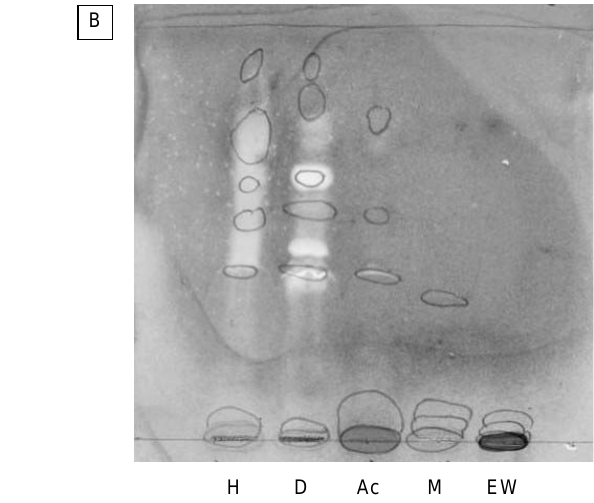
FIG. 1 Gunnera perpensa extracts separated on a TLC plate A: solvent system BEA (benzene:ethyl acetate:ammonia = 18:2:0.2) and sprayed with E. coli . B: solvent system CEF (chlo- roform:ethyl acetate:formic acid = 10:8:2) and sprayed with S. aureus. Extracts: H = hexane, D = dichloromethane, Ac = acetone, M = methanol, EW = ethanol/water